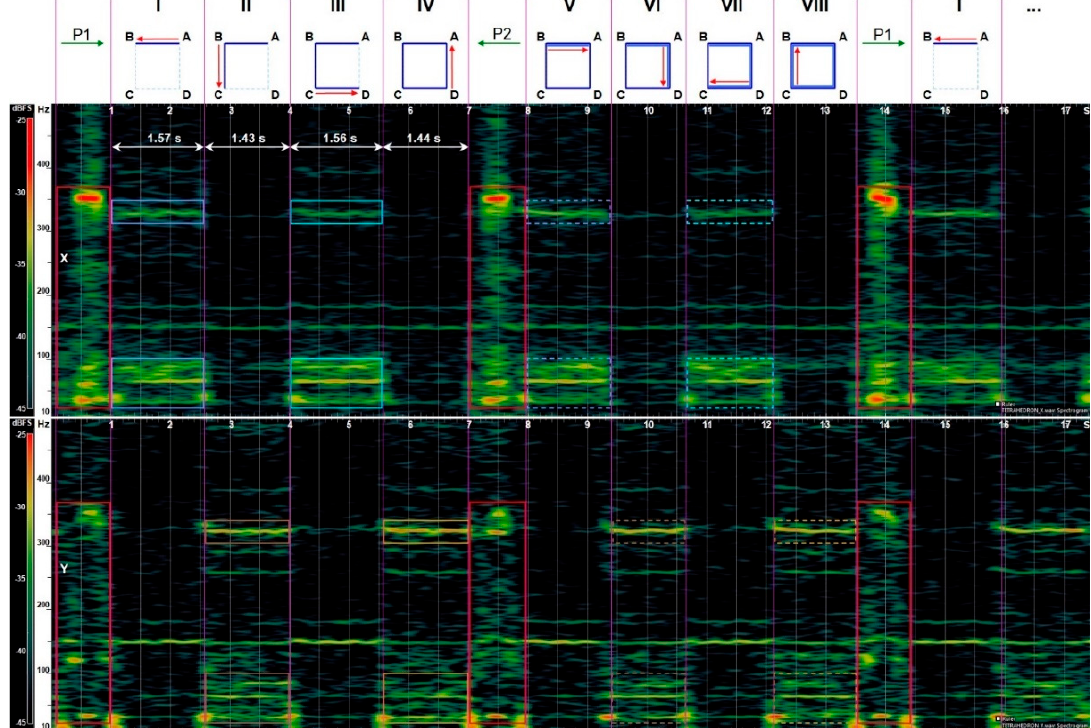
Figure 12. The spectrograms of printer vibrations when the tetrahedron object was printed. Condensation of the spectrum ranging from approx. 20 Hz to 370 Hz, marked with a red continuous line in spectrograms, informs about the movement of the platform and/or head positioning. Horizontal lines at a frequency of approx. 325 Hz on the X spectrogram and the spectrum condensations within the range of 20–100 Hz (the areas marked respec- tively with a continuous and a dashed dark blue/light blue line) inform about the head movement along the X axis. The same information regarding the head movement along